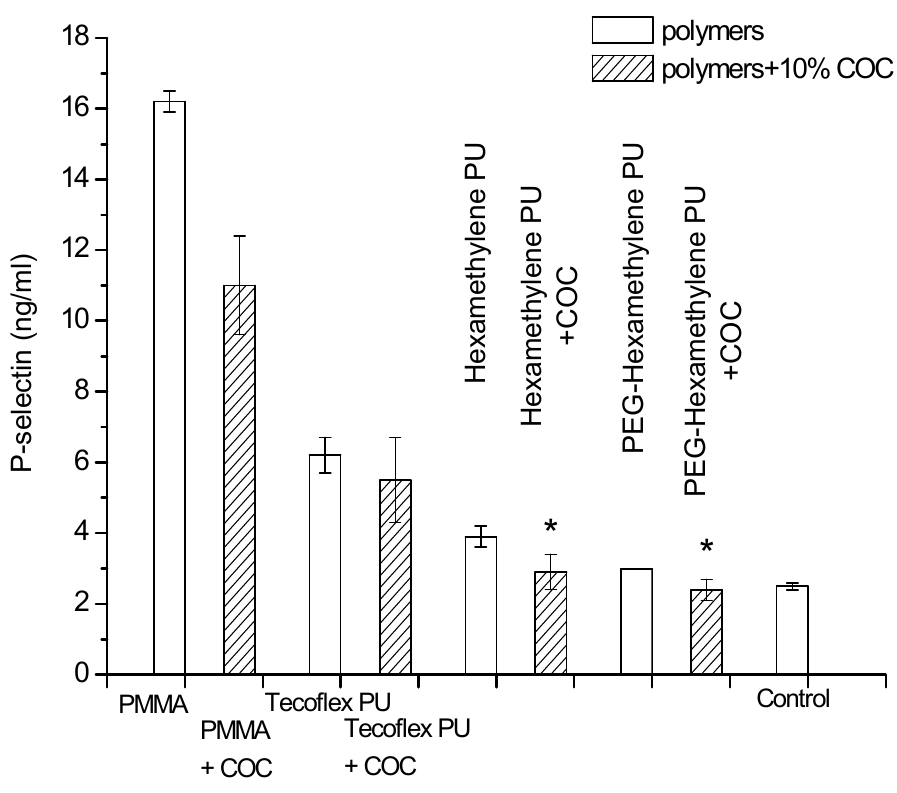
Figure 4. The effects of COC embedded in polymer composites on P-selectin levels. * P < 0.05 for hexamethylene PU + COC (10%) and PEG-hexamethylene PU + COC (10%) compared to their non-COC